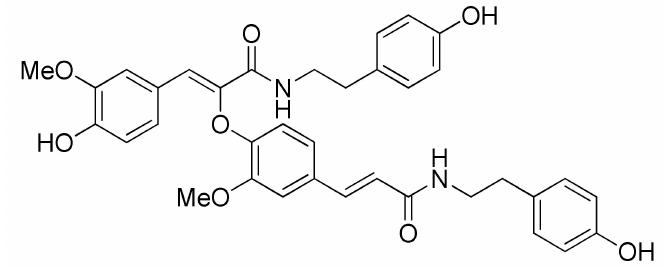
Figure 1. Structure of cannabisin